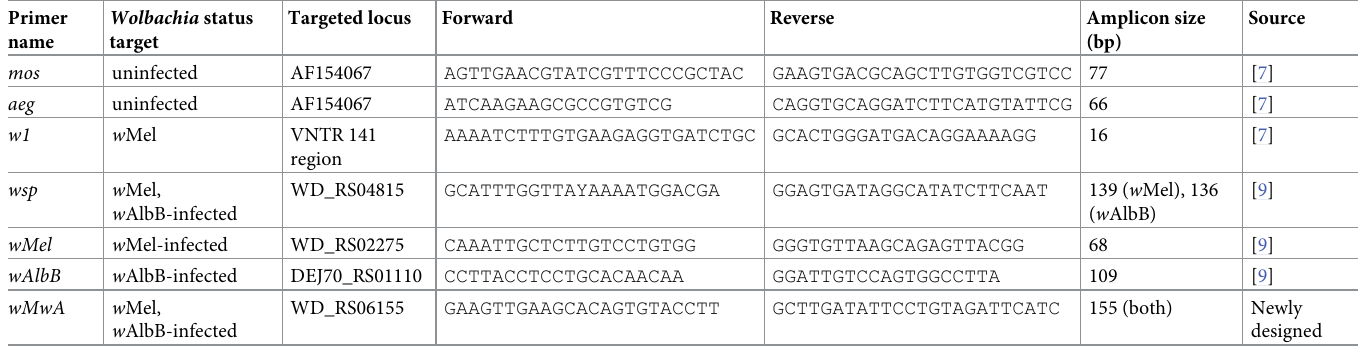
Table 1. Primers for detection of Wolbachia strains and estimation of